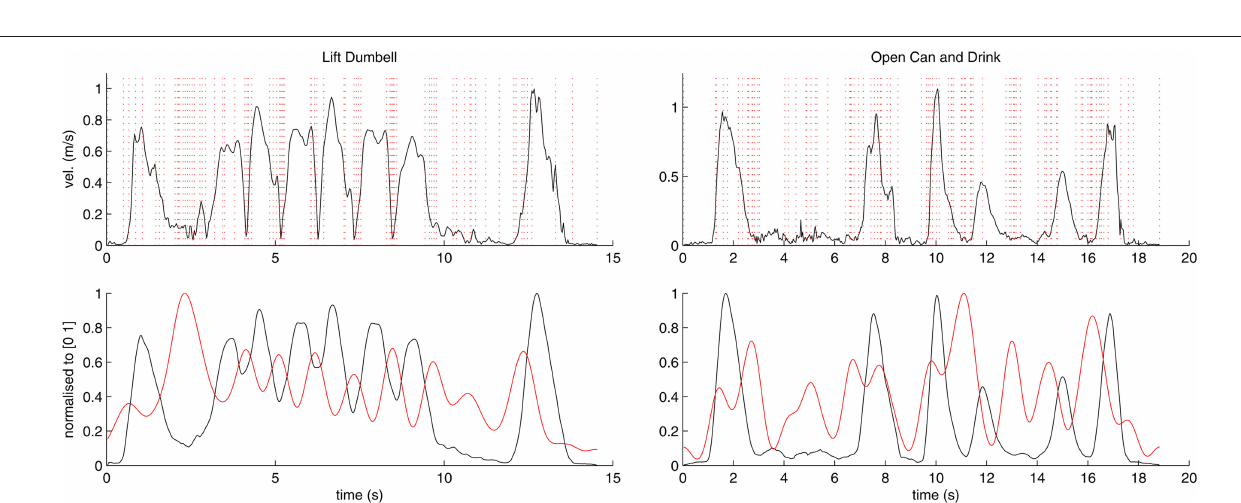
corresponding velocity after smoothing through a low-pass filter (black) as well as the density function computed from the marks placed by participants (red). Curves in the bottom row are normalized to the range of [0 1] for better